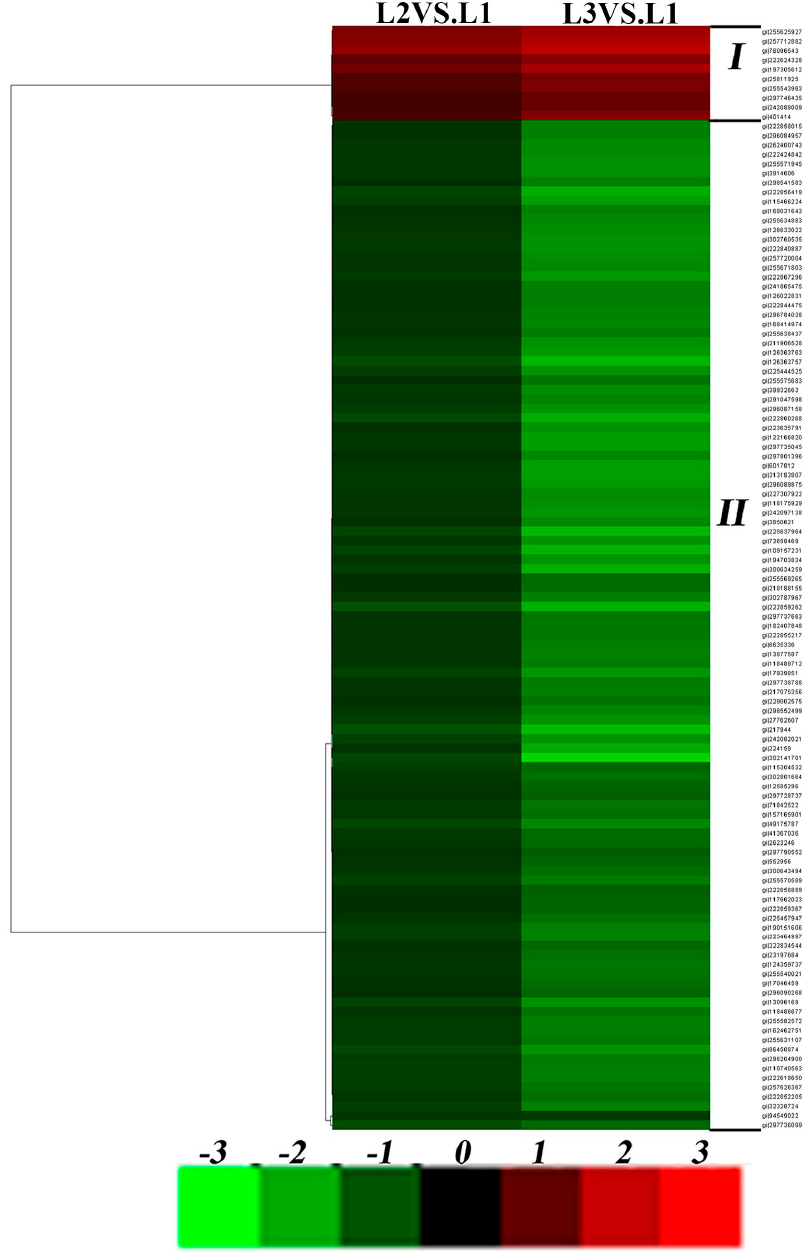
Figure 5. Hierarchical display of data from differentially expressed protein of leaves under drought stress. Upregulated proteins are in red; downregulated proteins are in green (for interpretation of the color references in the figure legend).